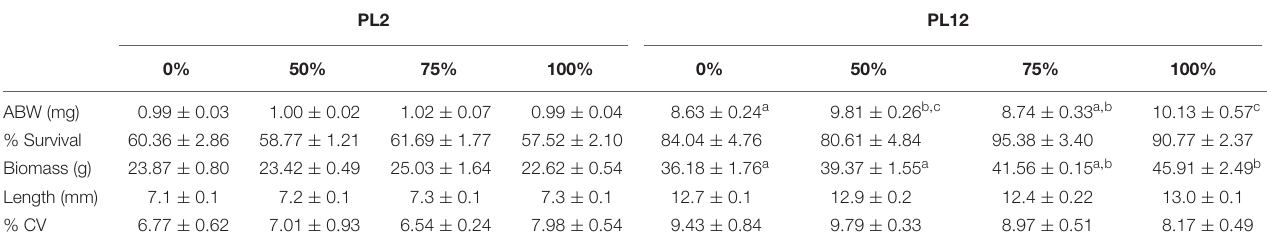
FIGURE 4 | Analysis of cholesterol and cholesteryl esters in feed and PL shrimp by LC-HRMS. Percent of meal replacement was percent of the number of meals for which TW was replaced by AL. Normalized abundance was derived from the peak intensity value normalized to that of tributyrin, the internal standard. Error bars represent standard errors ( N = 3). Statistical analyses of the PL2 and PL12 data sets were performed separately, using ANOVA. Significant differences among subsets of treatment groups were determined by Duncan’s multiple range test ( P < 0.05); subsets with means not significantly different from one another are identified with the same letter above the bar. Small- and big-capital letters are individually for the PL2 and PL12 data sets, respectively. Bars with no specified letters mean no significant differences were identified among the groups ( P > 0.05). TABLE 3 | Growth parameters of PL2 and PL12 shrimp fed with graded percent of meals supplied with AL in replacement of TW. PL2